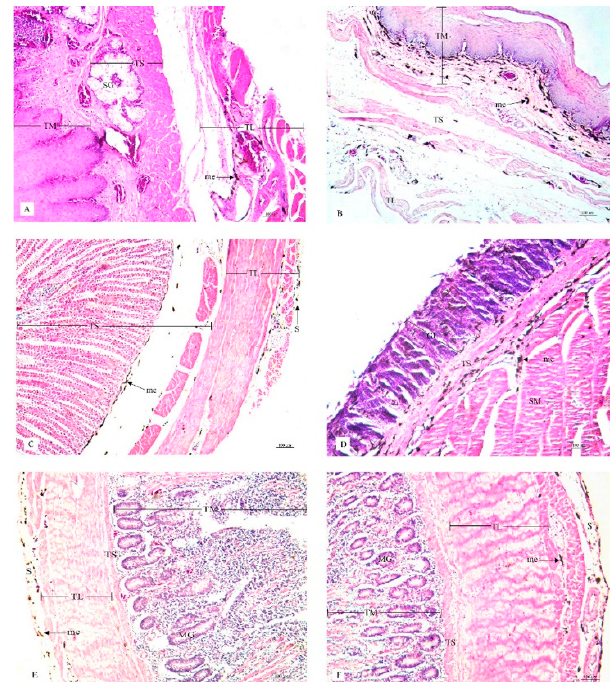
Figure 3. Histological location of melanin pigment in each organ; cloaca ( A ), oviduct ( B ), testis ( C ), gastrocnemius muscle ( D ), femur ( E ), tongue ( F ). Abbreviations: S, tunica serosa; TL, tunica muscularis; TS, tunica submucosa; TM, tunica mucosa; MG, mucous gland; E, epithelium; AN, tunica albuginia; LC, leydig cells; ST, seminiferous tubule; Ep, epimysium; Pr, perimysium; En, endomysium; MF, muscle fiber; PO, periosteum; CB, compact bone; CM, medullary cavity; E, epithelium; C, cartilage; me, melanin pigment. Low magnification, H&E stain.